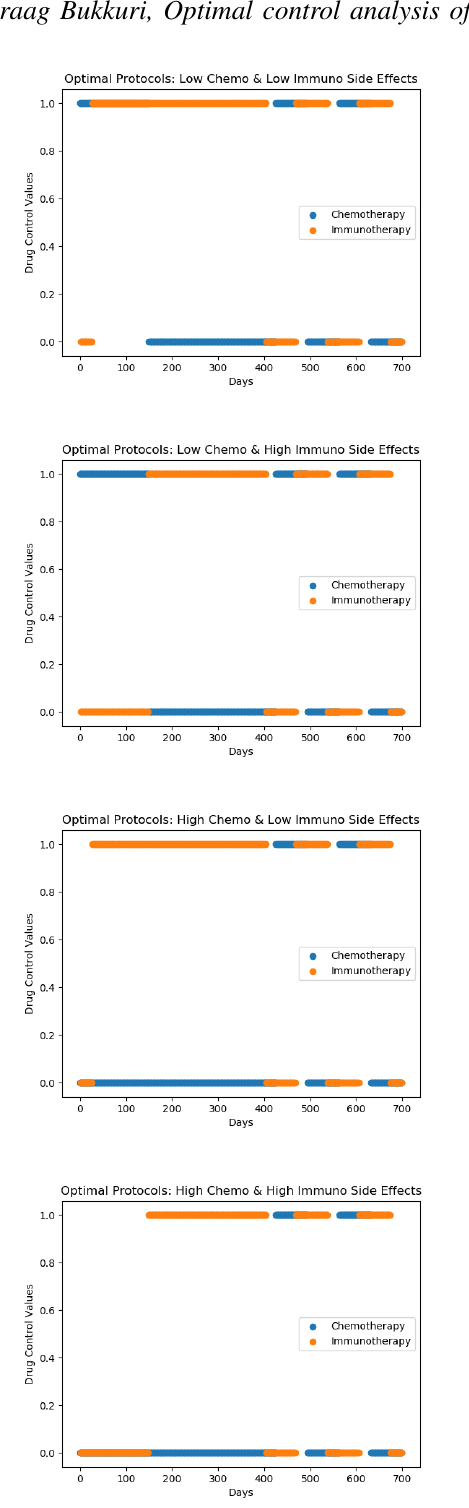
Fig. 5. Numerical Simulations of Optimal Control Profiles for a Hypothetical